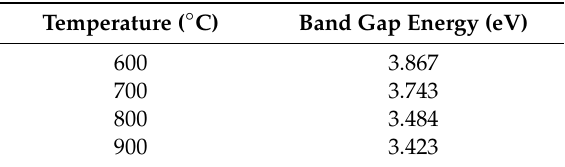
Figure 4. Absorption spectra for 55ZnO–5B 2 O 3 –40SLS based glass and glass-ceramic sintered at different temperatures. Table 3. Variation of optical band gap against heat-treatment